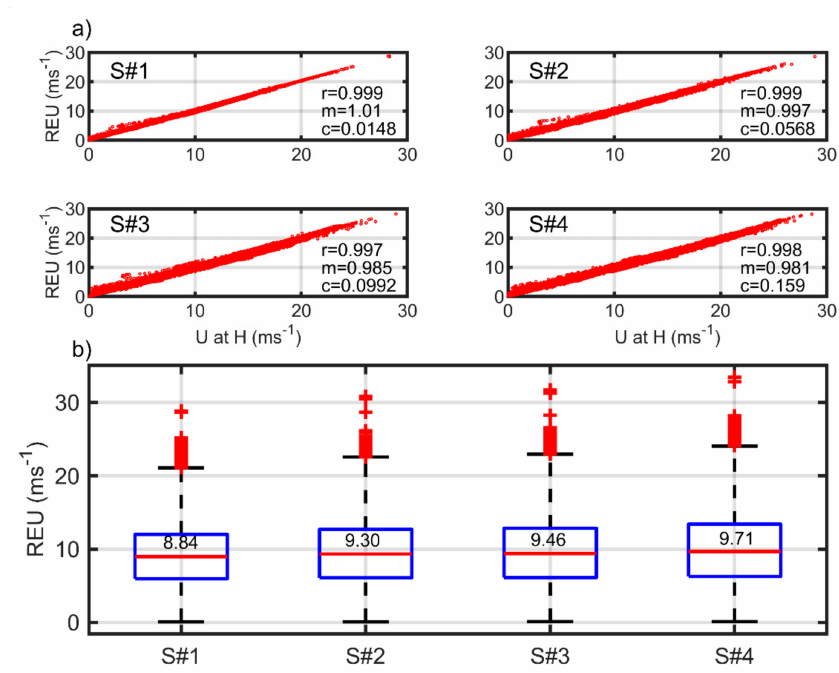
Figure 5. ( a ) Four scatterplots showing the rotor equivalent wind speed ( REU ) vs. hub-height median wind speeds for the WT scenarios S#1–S#4 for Site 1. The numbers in the lower right corner of each sub-panel are the Pearson correlation coe ffi cient (r), the slope (m) and the intercept (c). ( b ) Box-whisker plot showing median, 25% and 75% quartiles (the limits on the boxes) of 10-min REU for the four WT scenarios at site 1. Whiskers extend to the 1st to 99th percentile values of REU (ms − 1 ). The number in the center of the box indicates median hub-height wind speeds for each WT